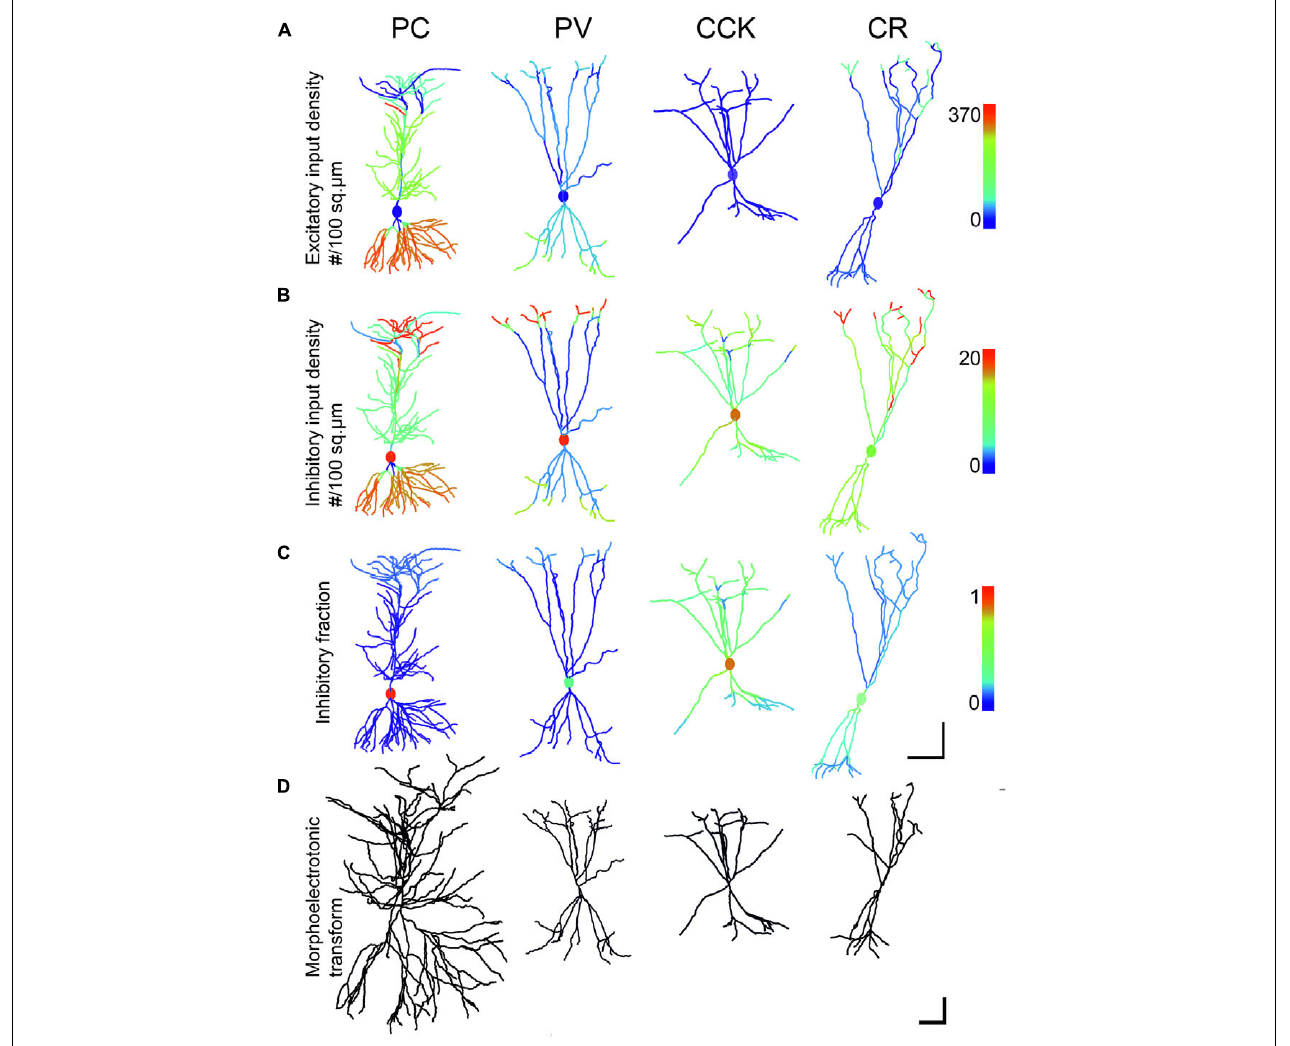
FIGURE 3 | Comparison of input density, excitatory to inhibitory ratio and morphoelectrotonic length of modeled neurons. (A,B) The first and second rows show the excitatory and inhibitory input densities per membrane surface for the four examined cell types, presented on the same color scale for the same type of inputs. These values were used in the simulation when calculating convergent synaptic inputs in different states. Note that the PC receives the densest excitatory input onto its second order dendrites. (C) The third row shows the ratio of inhibitory inputs over the compartments. Inhibition is centered on the soma for all neurons. PC perisomatic regions get almost exclusively inhibition. CCK cells receive the highest amount of inhibitory input. (D) The fourth row shows the morphology of neurons after morpho-electrotonic transformation taking into consideration dendritic diameters. PCs are the least compact due to the small diameter of the second order oblique basal and apical dendrites that constitute the majority of dendritic compartments. Interneurons are more compact, due mainly to thicker higher-order dendrites. Scale: (A–C) 100 µ m; (D) 1 lambda (electrotonic length